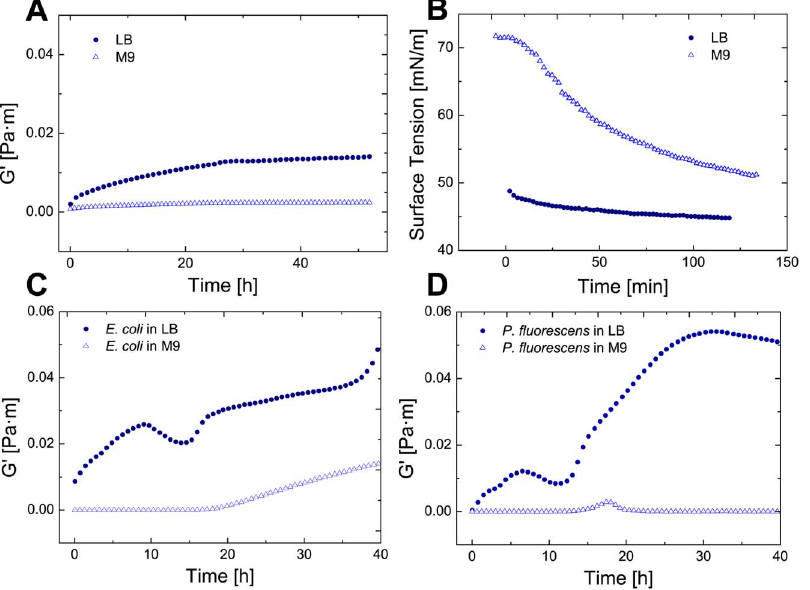
Figure 2. Interfacial elasticity and surface tension of LB and M9 media and bacterial growth in LB and M9 media. A: Interfacial rheology of the pure LB and M9 media at 25 u C for 50 hours. B: The surface tension is plotted against the time of pure LB and M9 media. C: The interfacial elasticity is measured of E. coli incubated in M9 and LB media. D: The interfacial elasticity is measured of P. fluorescens incubated in M9 and LB media.